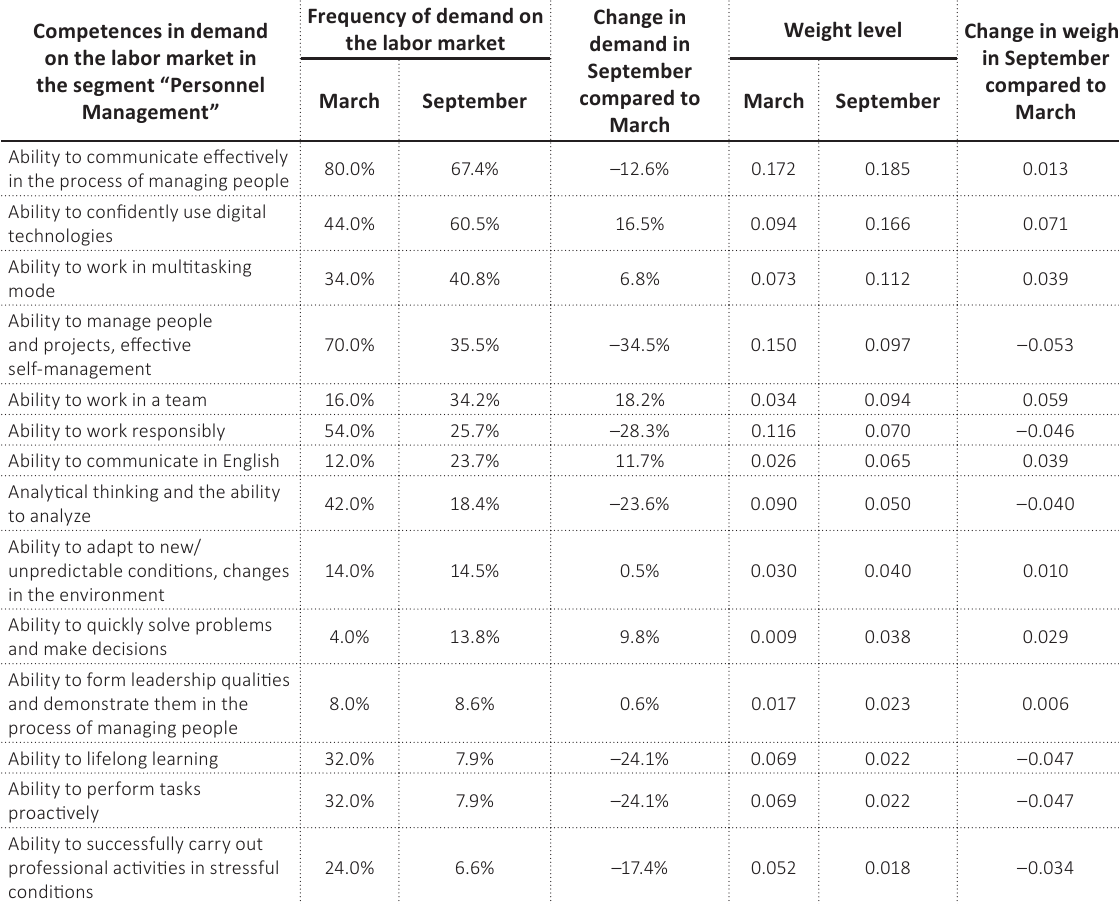
Table 2. Demand for transferable competencies of personnel managers on the labor